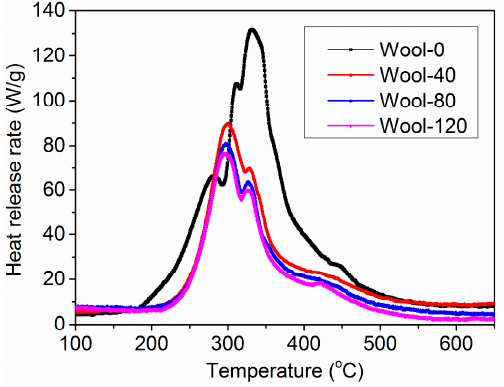
Figure 7. HRR curves of the wool fabrics from the PCFC test. Table 1. PCFC parameters for the wool fabrics treated with PA.